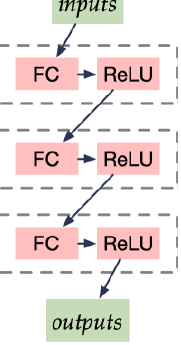
Figure 7. MLP projection layer structures.